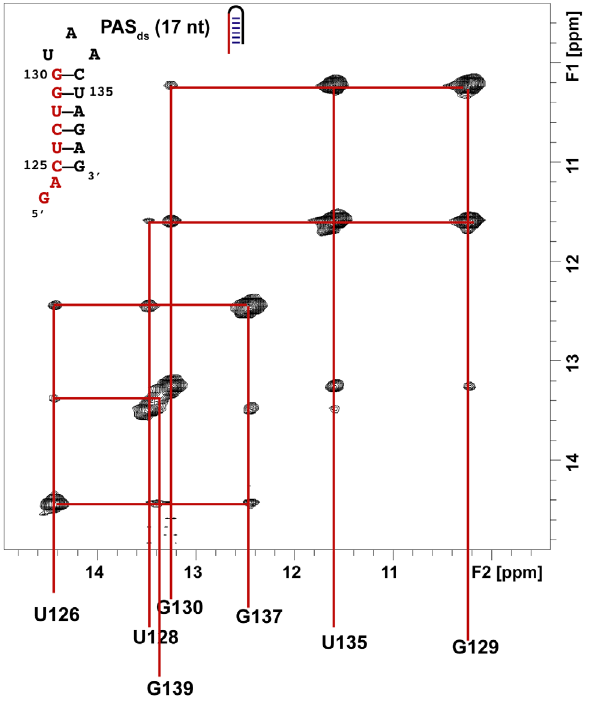
Figure 4. Assignment of the imino proton resonances of PAS ds . NOESY experiment recorded at 15 u C with a mixing time of 150 ms with a sample of PAS ds at 1.6 mM in a phosphate buffer (10 mM, pH 6.5) with 50 mM KCl.